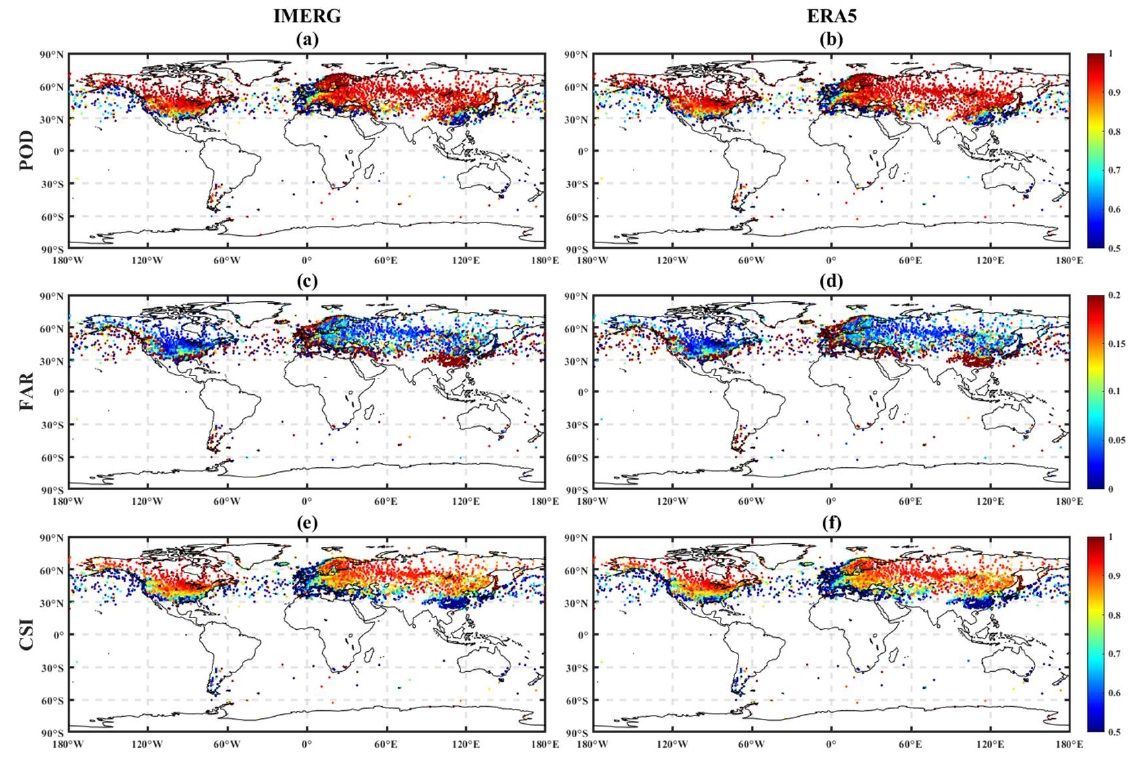
Figure 3. Spatial distributions of POD, FAR, and CSI metrics for IMERG and ERA5. The subplots ( a , c , e ) refer to the POD, FAR, and CSI metrics for IMERG. The subplots ( b , d , f ) refer to the POD, FAR, and CSI metrics for ERA5.